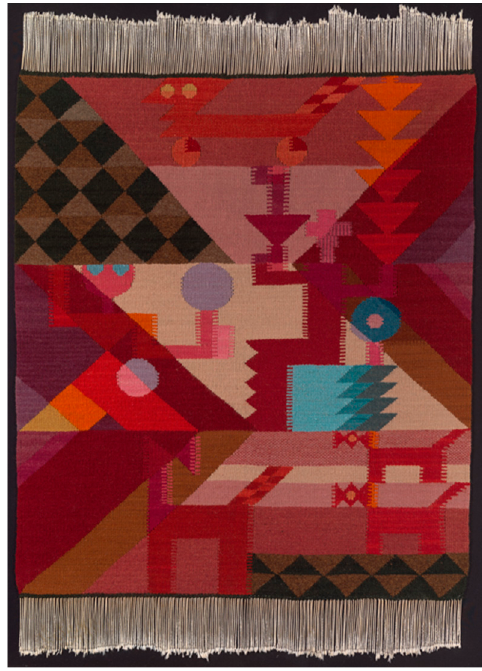
Figure 15. Sophie Taeuber-Arp, Rug, Untitled, 1918. Wool, woven. 80 cm × 69.5 cm. Fondazione Marguerite Arp-Hagenbach, Locarno. © SIK-ISEA, Zürich (photo Philipp Hitz), used by permission.